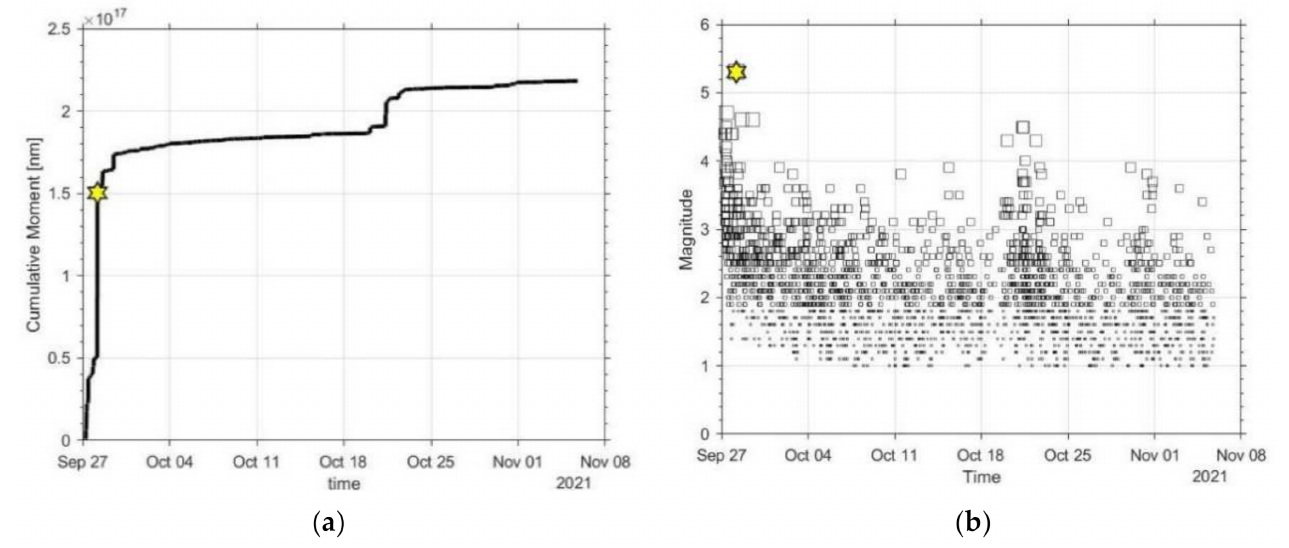
Figure 11. Cumulative seismic moment release ( a ) and magnitude distribution versus time ( b ) for the aftershocks occurring up to 5 November 2021. Star shows the largest aftershock (M w 5.1/M L 5.3) that occurred on 28 September